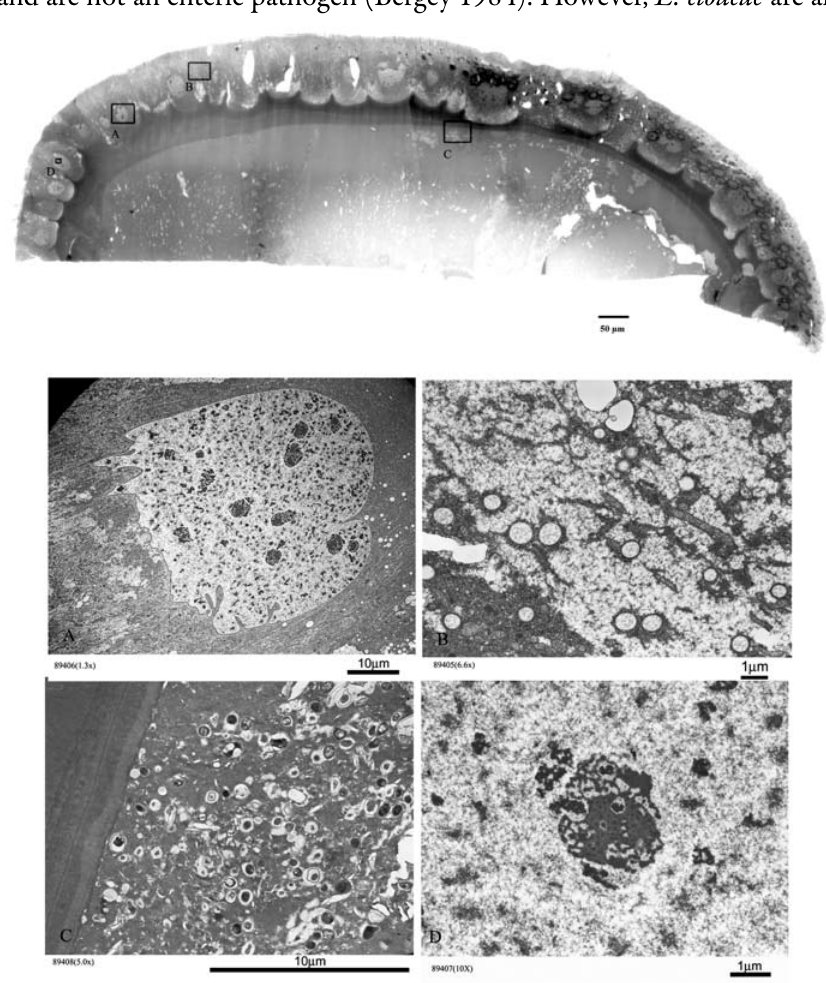
Fig. 8. cross-section of the hindgut of a fourth-instar